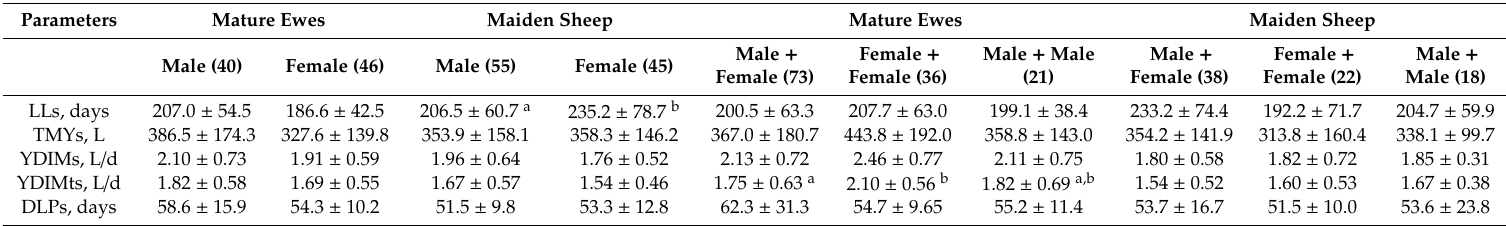
Table 7. Productive parameters in mature ewes and maiden sheep with male and / or female o ff spring during subsequent lactation.